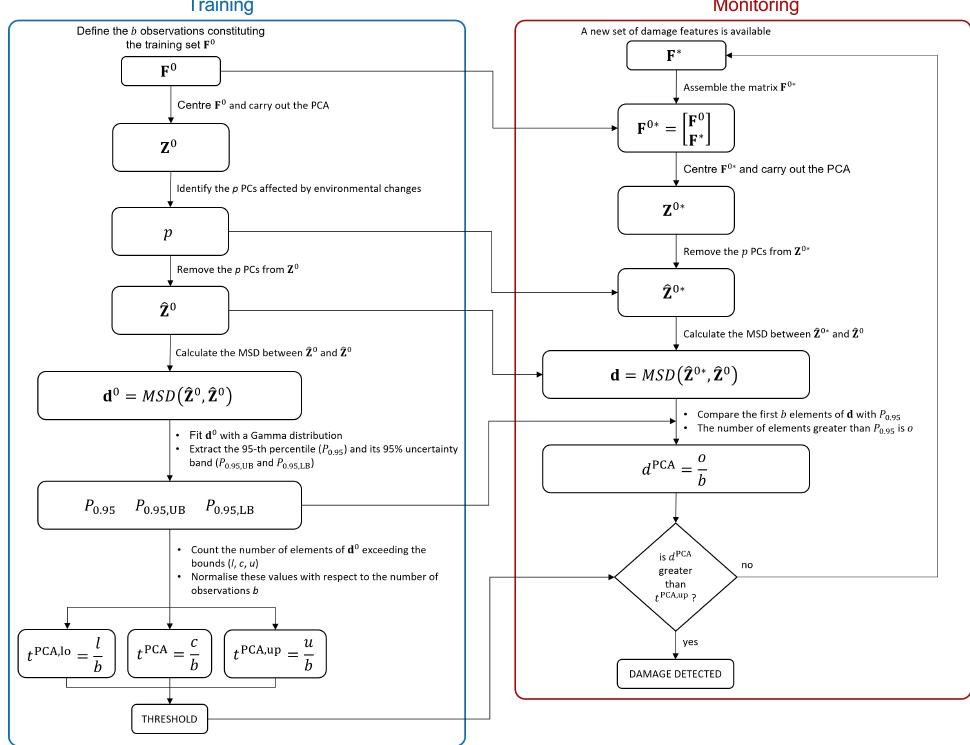
Figure 2. Flowchart of the PCA-based